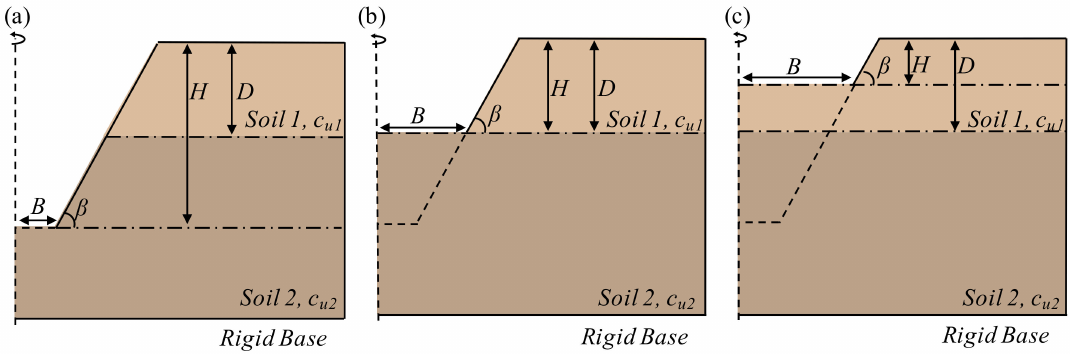
Figure 2. A schematic diagram of depth ratio variation ( a ) D / H < 1, ( b ) D / H = 1, and ( c ) D / H > 1.